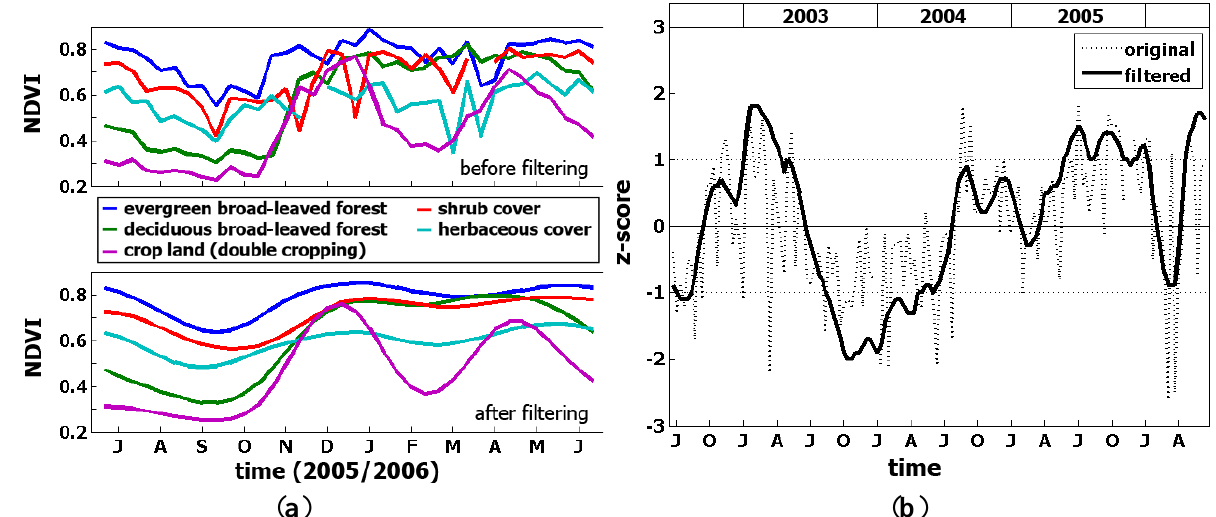
Figure 1. Illustration of positive filtering effects on satellite-derived (10-daily) NDVI time series (from Atzberger and Eilers [31]; modified). For filtering and gap filling, the Whittaker smoother was used. The NDVI time series are from SPOT-VGT. ( a ) Example NDVI profiles from different land cover types before (top) and after (bottom) smoothing with the Whittaker filter. The profiles were randomly extracted within the state of Mato Grosso in Brazil; ( b ) Effects of the smoothing on vegetation anomalies (z-scores) over a randomly selected grassland pixel in Mato Grosso